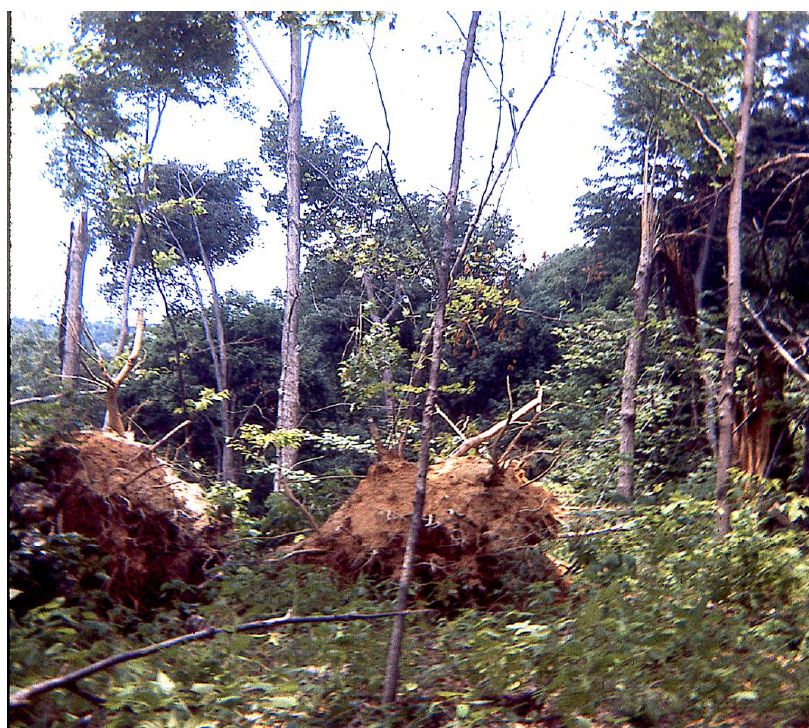
Figure 1. Windstorm damage to the forest community at Dinsmore Woods, June 1974. Scene is representative of the damage seen throughout this site. Uprooted trees are in the foreground with bent and snapped trees seen in the background.